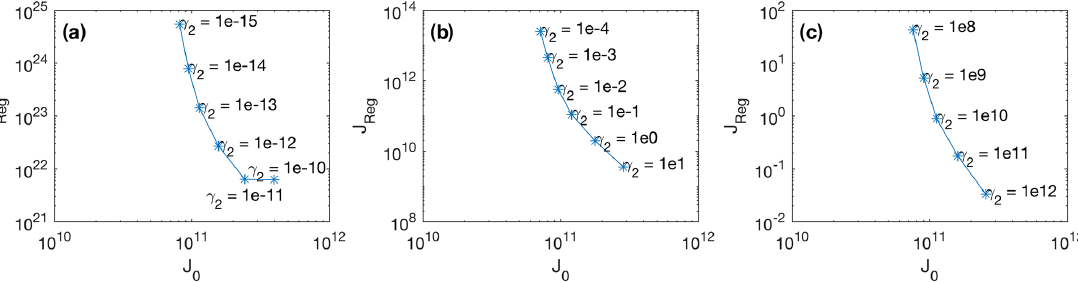
Figure 3. Log–log plot for L-curve analysis of inversions of the Russell Glacier area employing (a) linear sliding law, (b) Budd sliding law, and (c) Schoof sliding law.